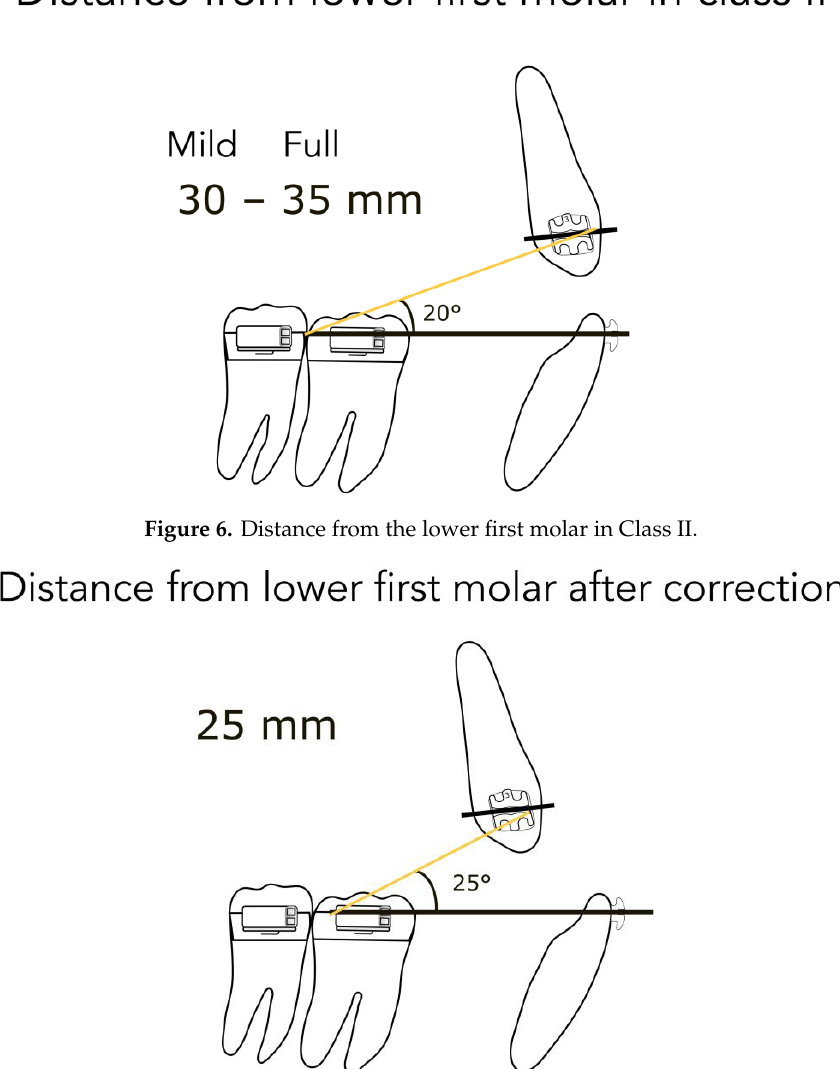
Figure 5. Distance from the lower second molar after correction.